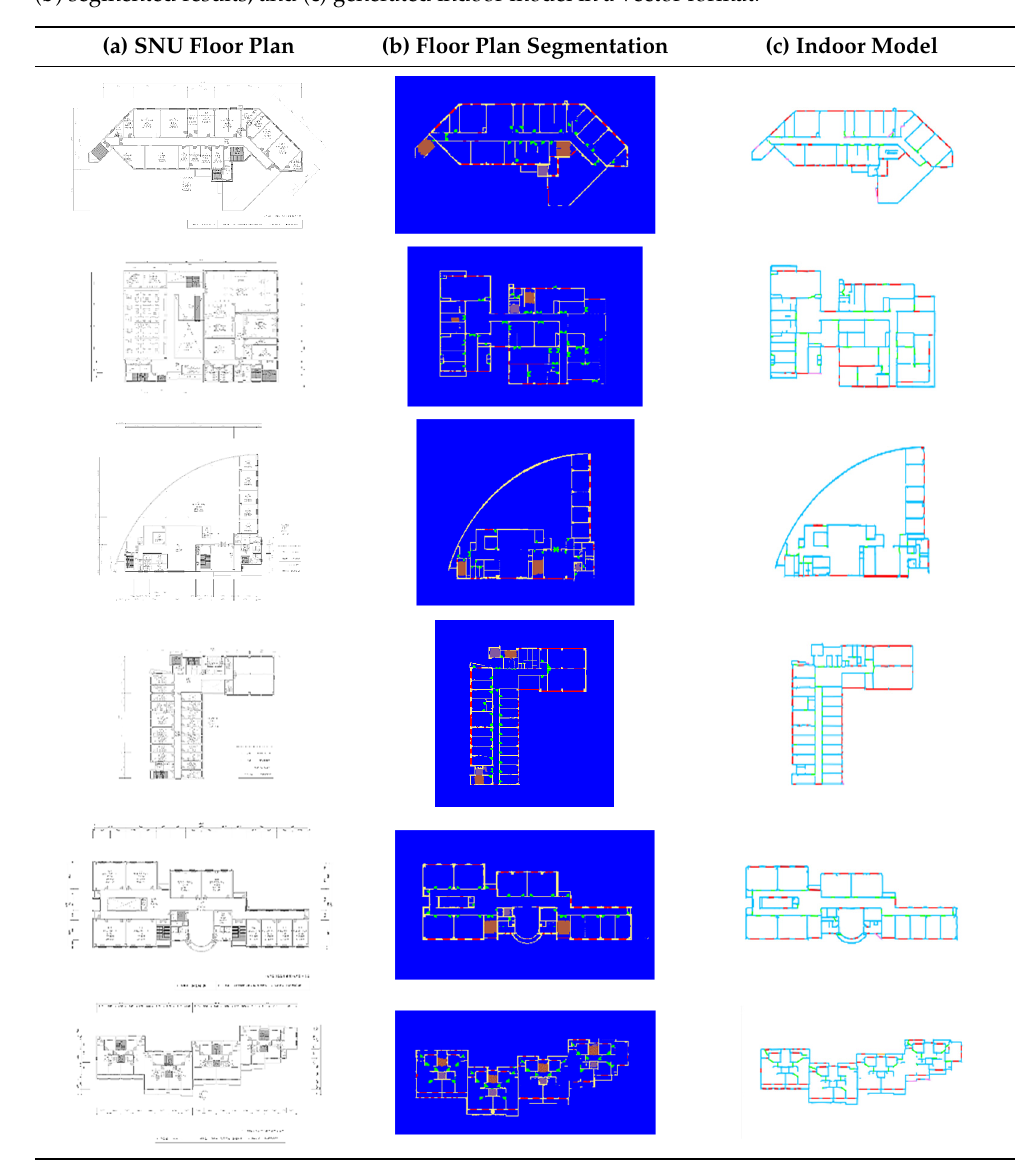
Table 1. Results of the proposed model on SNU dataset. From left to right, ( a ) input floor plan, ( b ) segmented results, and ( c ) generated indoor model in a vector format.